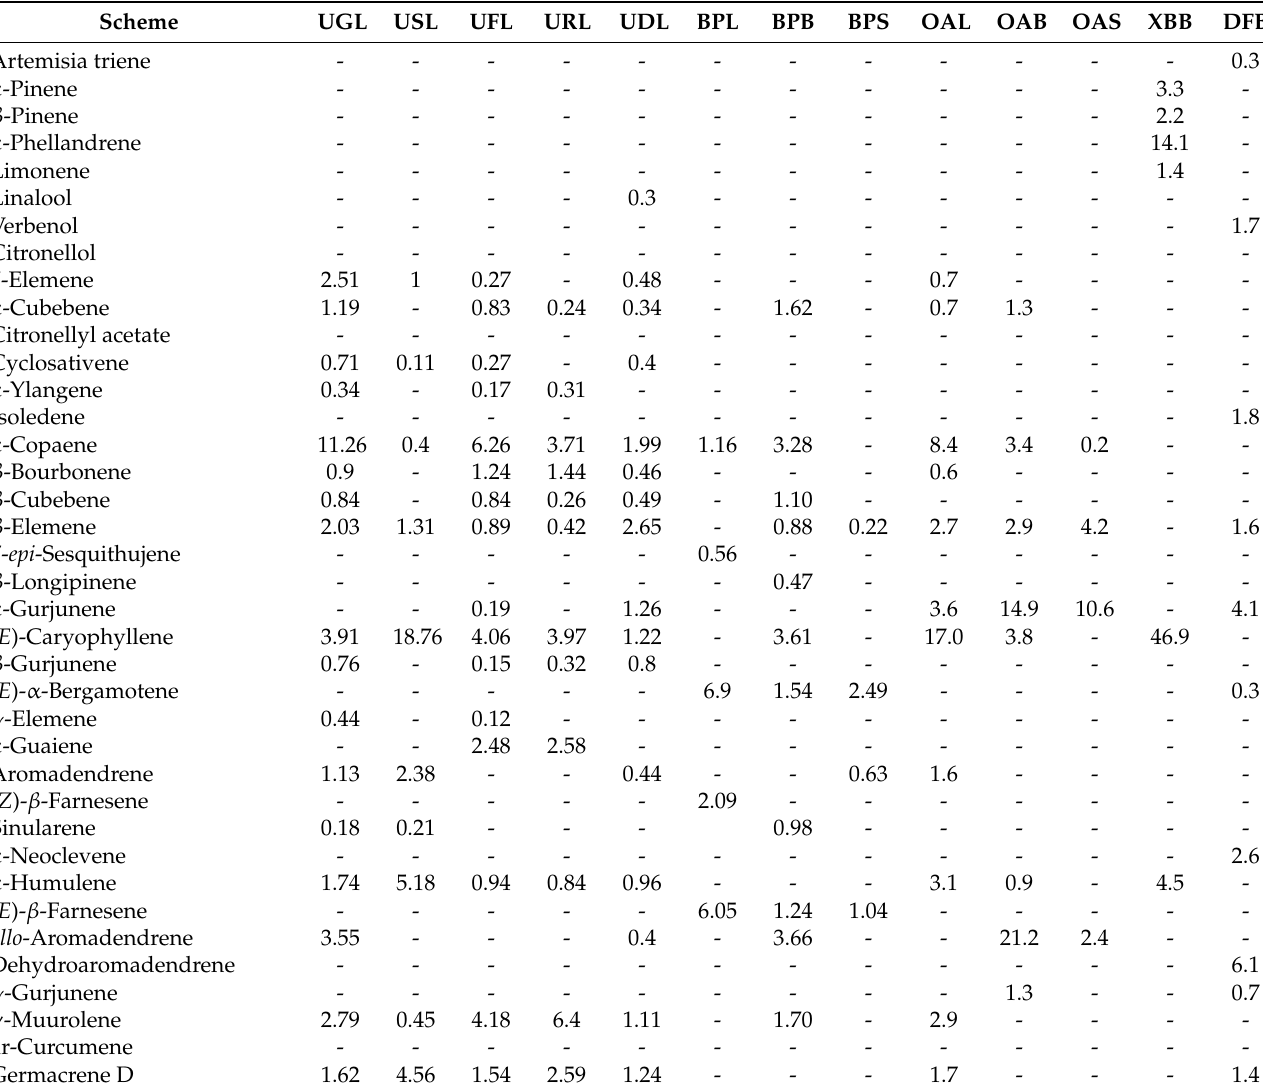
Table 1. Essential oil composition of previously reported Unonopsis , Bocageopsis and Onychopetalum species, along with Duguetia flagellaris and Xylopia benthamii . In this table: UGL = leafs of Unonopsis guatterioides ; USL = leafs of U . stipitata ; UFL = leafs of U. floribunda ; URL = leafs of U. rufescens